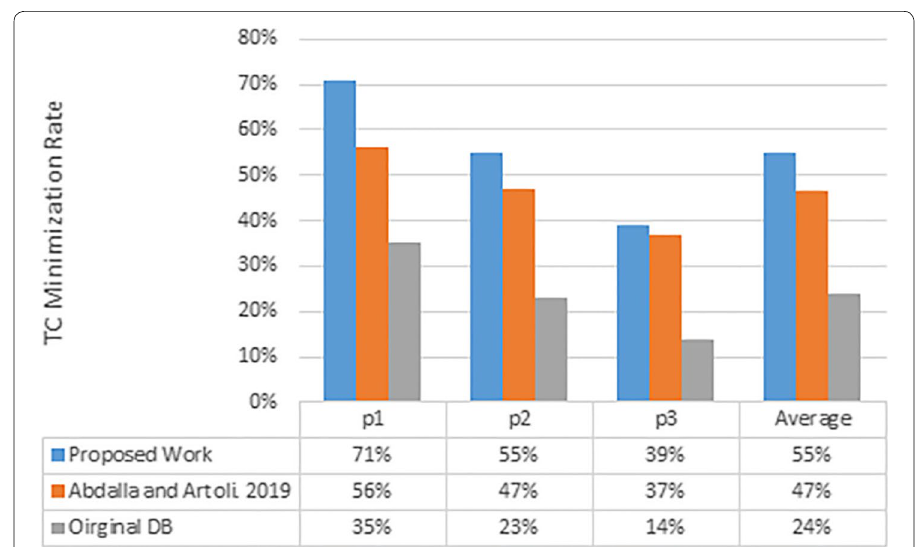
Fig. 11 Scenario 1—TC minimization in percentage: take the average TC over all problems